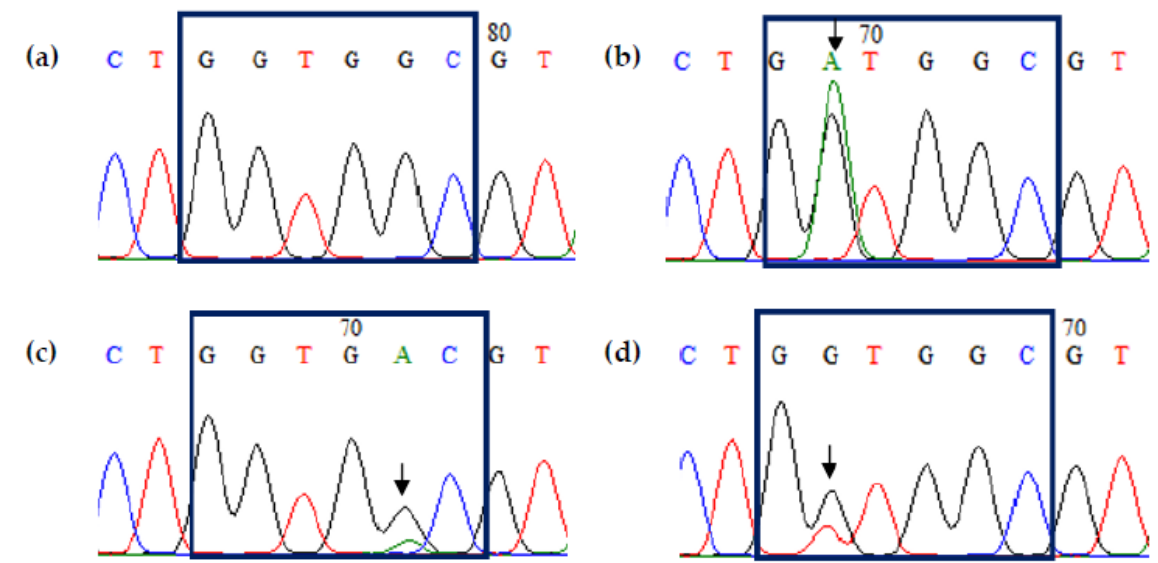
Figure 3. Chromatogram highlighting codons 12 and 13 of KRAS in selected cases. Arrows indicate the location of the single-point mutations. ( a ) Wild-type KRAS sequence (GGT GGC); ( b ) c.35G > A (G12D) mutation in case 4; ( c ) c.38G > A (G13D) mutation in case 9; ( d ) c.35G > T (G12V) mutation in case 12.